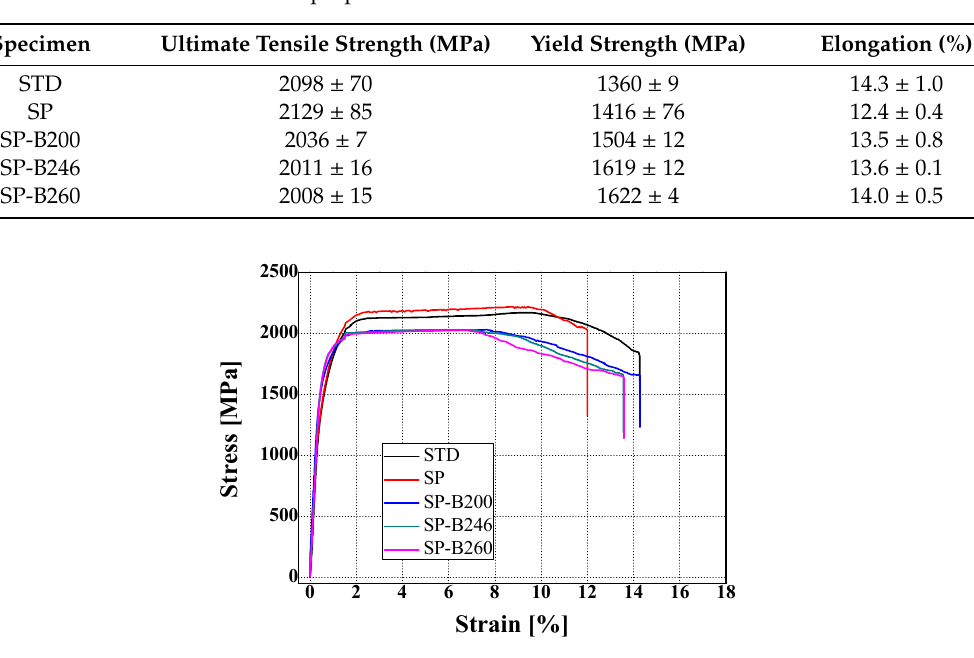
Figure 6. Stress–strain curves of the 4340M steel obtained from tensile test.